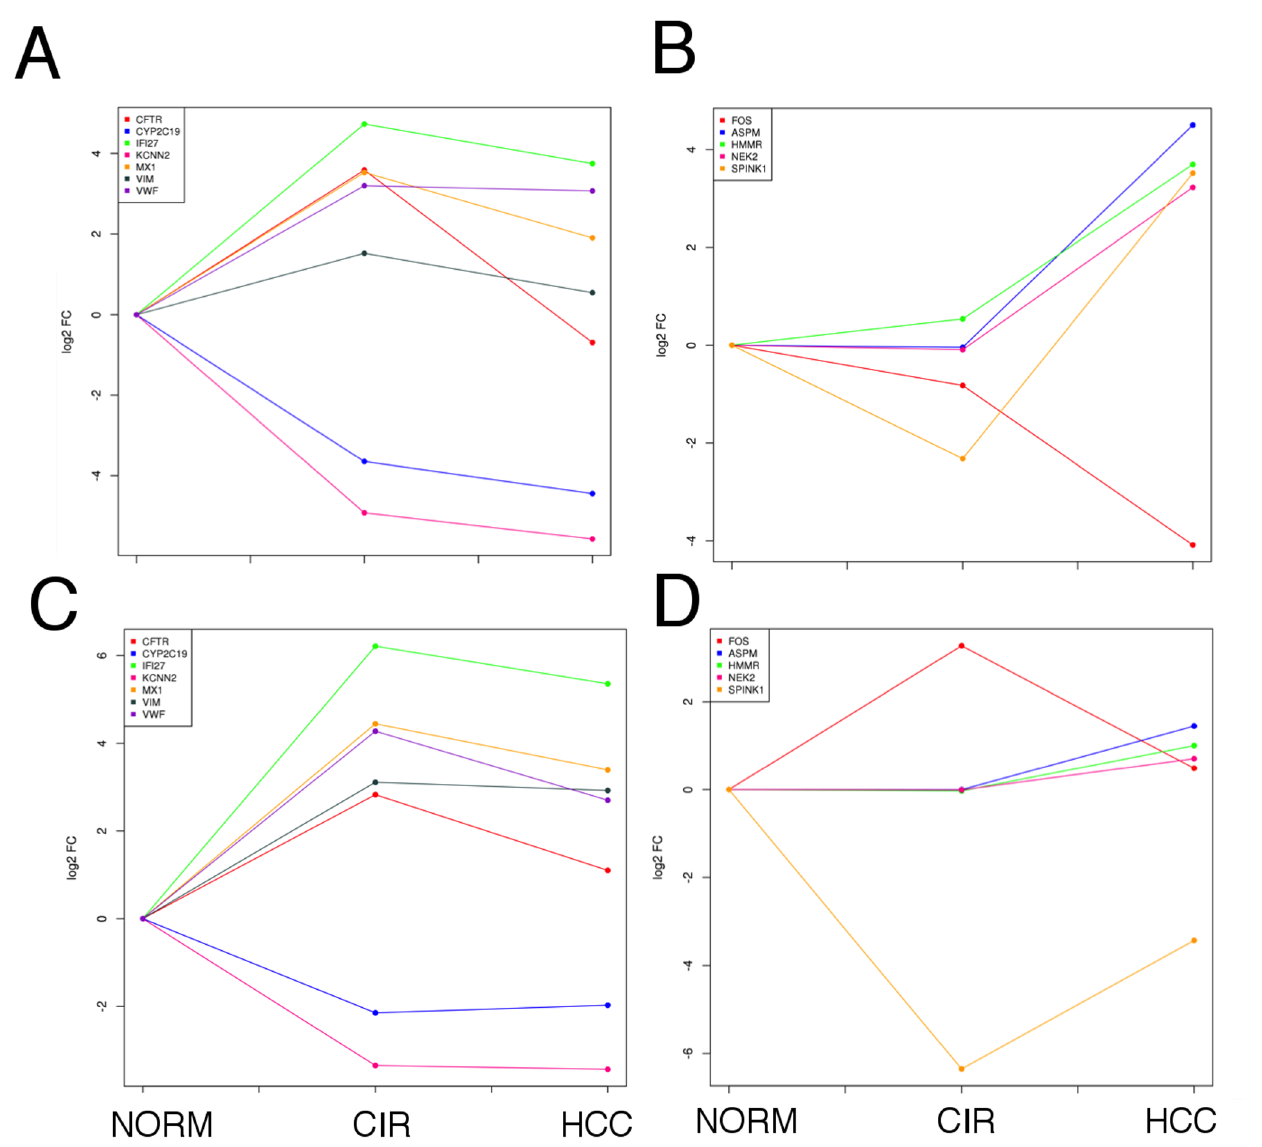
Figure 7. Expression variation in normal, cirrhotic and hepatocellular carcinoma samples of the most differentially expressed proteins that lie in network proximity to HCV targets. Mean log 2 fold change (vertical axis) in NORM, CIR and HCC samples (horizontal axis). A, C : genes derived from the CIR-NORM summary PPI network (Fig. 5A). B, D : genes derived from the HCC-CIR summary PPI network (Fig.